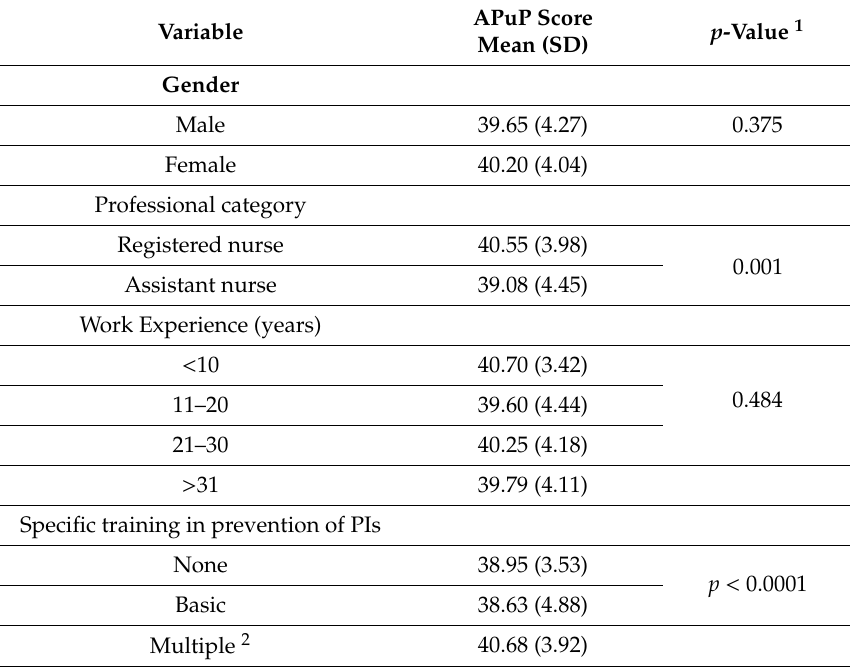
Table 8. Attitude score with APuP questionnaire in di ff erent